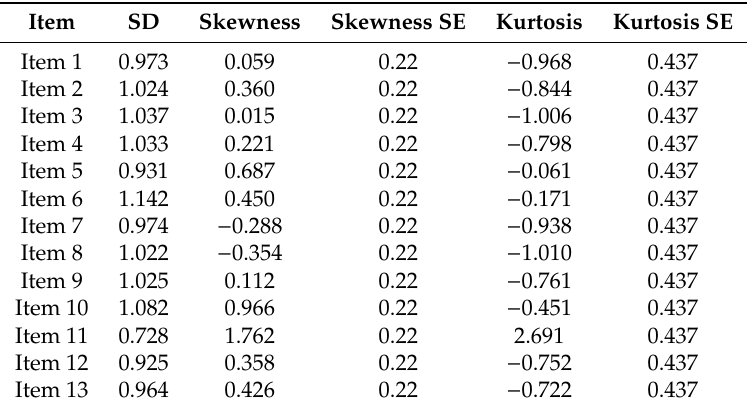
Table 2. Standard Deviation, skewness, and kurtosis indicators.